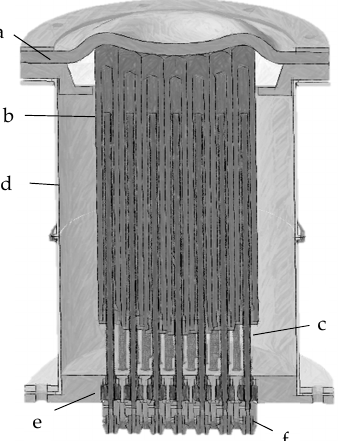
Figure 3. Principle of vacuum-assisted multipoint moulding (VAMM), shown in a smaller test setup. The setup from top to bottom: ( a ) interpolation layer, ( b ) pin array, ( c ) threaded rods, ( d ) vacuum container, ( e ) base plate and ( f ) actuator couplings [23].